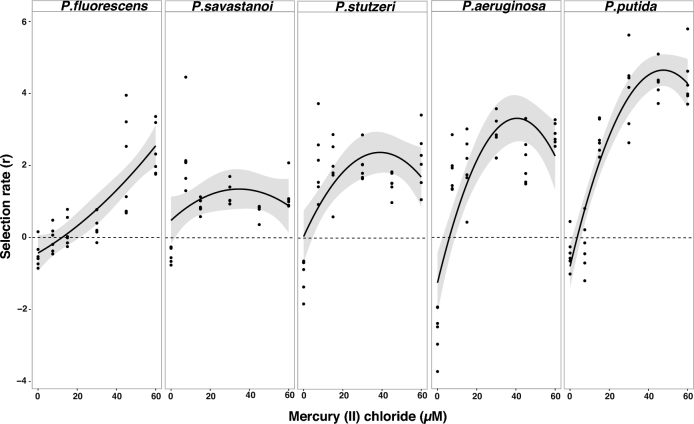
Fitness of Pseudomonas species carrying the plasmid measured as selection rate in a mercury regime ranging from 0–60 μΜ mercury (II) chloride. Solid circle (•): each clonal population carrying the plasmid and competing with the isogenic wild-type strain; solid line (-): curve fitting mercury as a quadratic term for each species; dashed line (–): selection rate 0 indicates no difference between test and reference strains; shaded area: confidence interval of fitting curve.